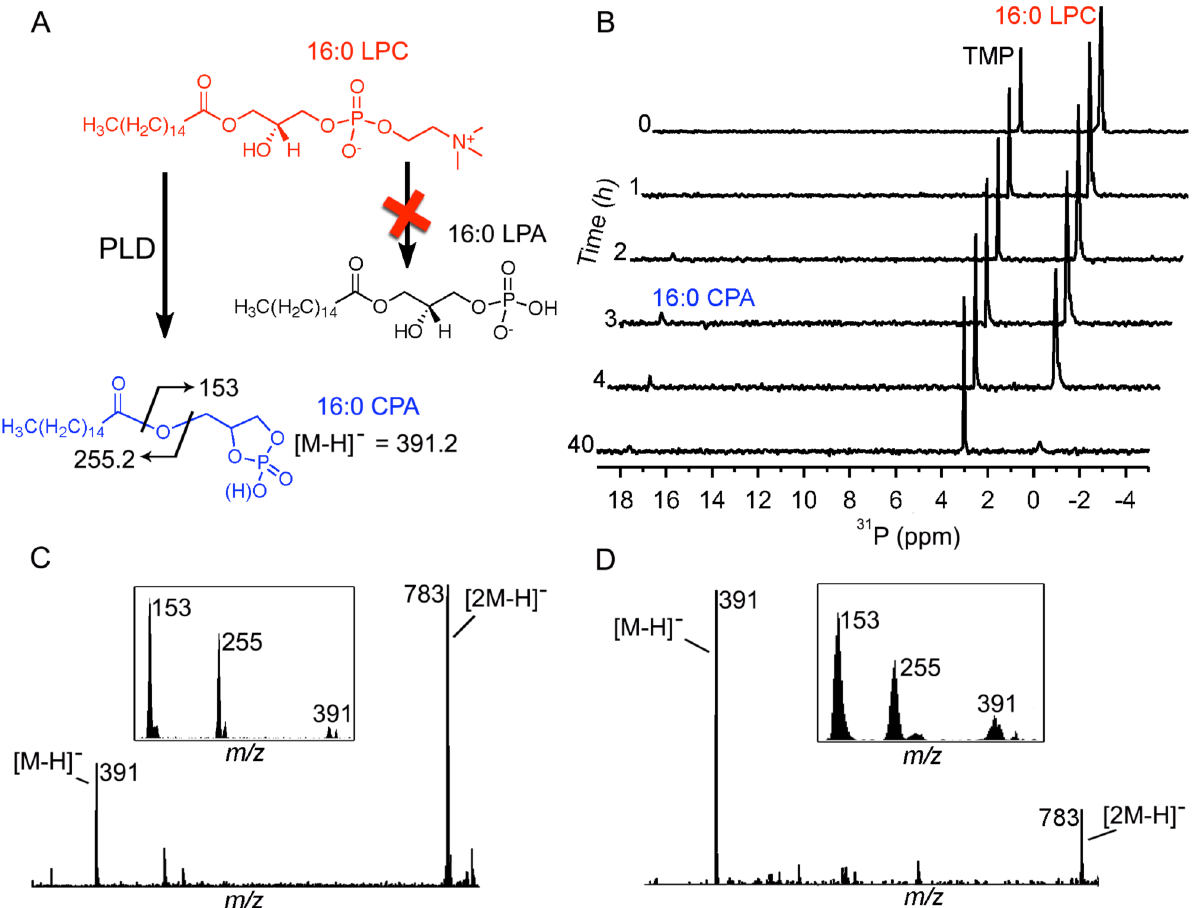
Figure 1. Action of recombinant SicTox PLD enzyme a IB2bi on palmitoyl lysophosphatidylcholine (16:0 LPC). (A) No palmitoyl lysophosphatidic acid (16:0 LPA) is detected, but palmitoyl cyclic phosphatidic acid (16:0 CPA) can be detected as a product by NMR and